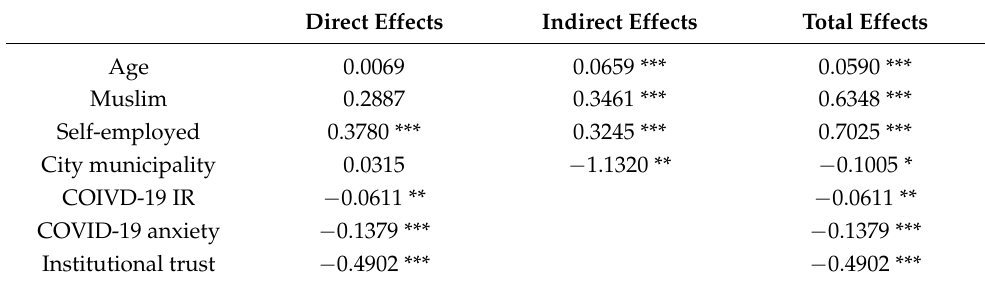
Table 5. Direct, indirect, and total effects,